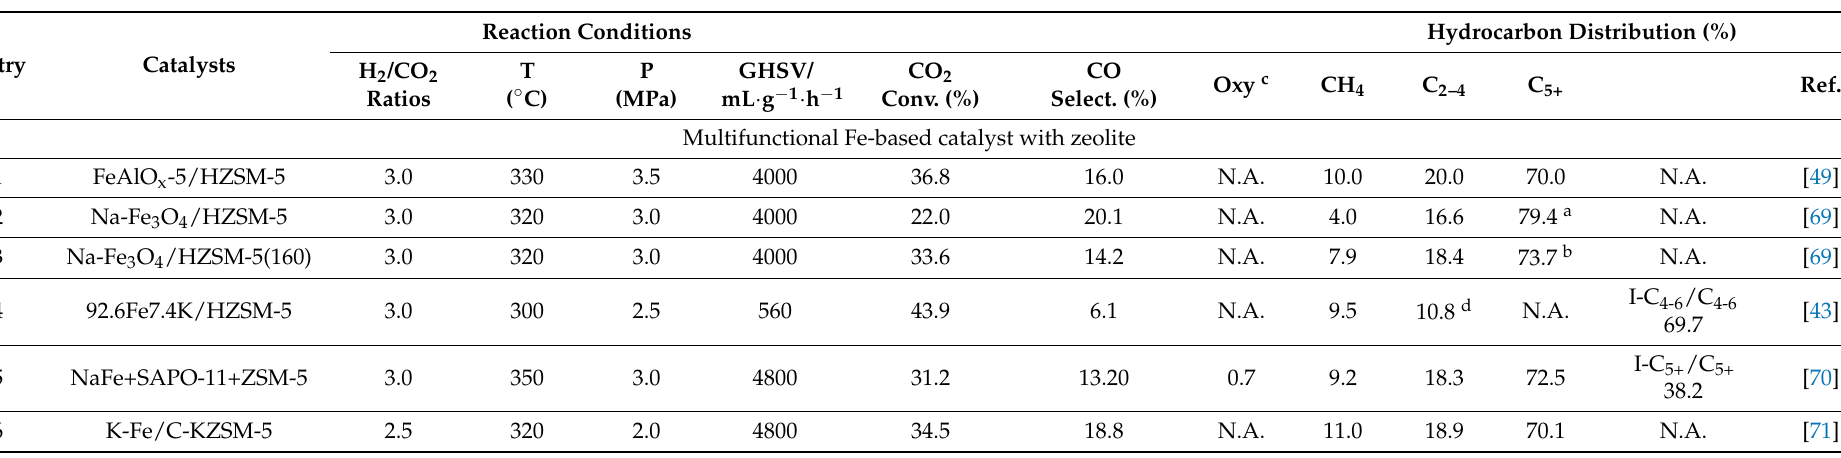
Table 2. Representative catalysts and their performance for direct hydrogenation of CO 2 to